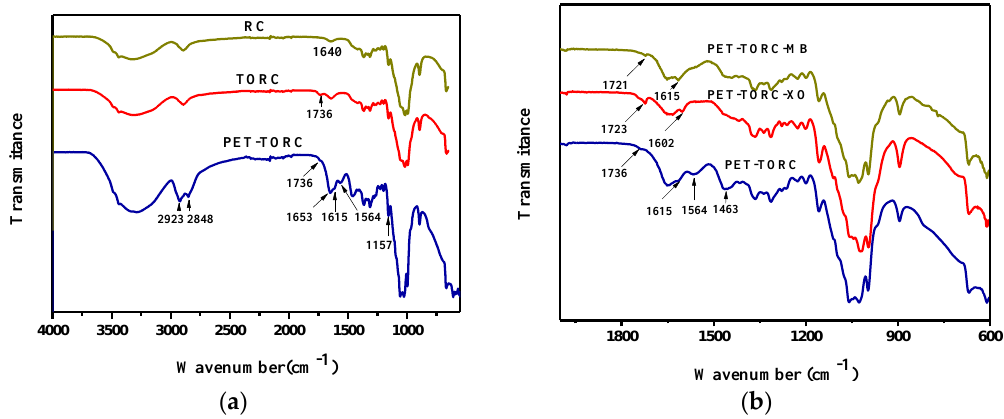
( a ) ( b ) Figure 1. ( a ) FTIR spectra of RC, TORC, Figure 1. ( a ) FTIR spectra of RC, TORC, polyethylenimine(PEI)-(2,2,6,6-tetramethylpiperidin-1-yl)oxyl polyethylenimine(PEI)-(2,2,6,6-tetramethylpiperidin-1-yl)oxyl (TEMPO)-oxidized regenerated (TEMPO)-oxidized regenerated cellulose (TORC); ( b ) FTIR spectra of xylenol orange (XO)-adsorbed cellulose (TORC); ( b ) FTIR spectra of xylenol orange (XO)-adsorbed PEI–TORC and MB-adsorbed PEI–TORC.